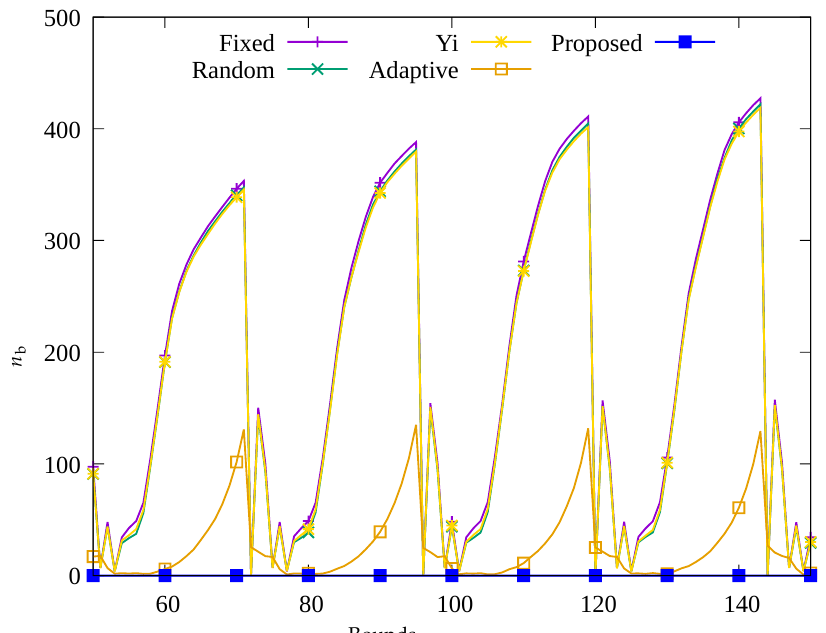
Figure 4. Change in the number of blackout nodes over